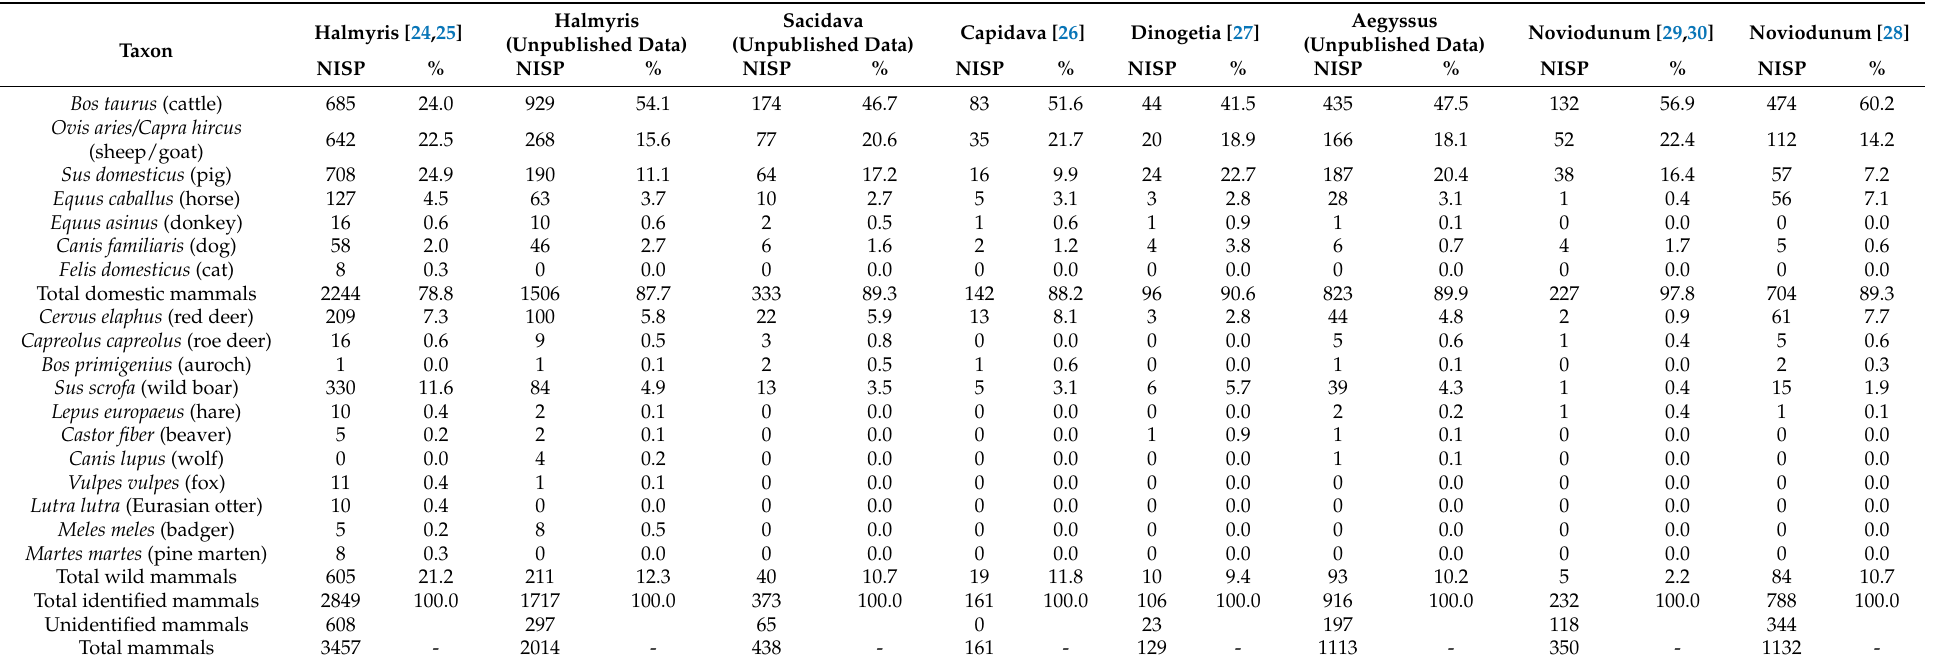
Table 4. Quantification of mammal remains by NISP (number of identified specimens) in the